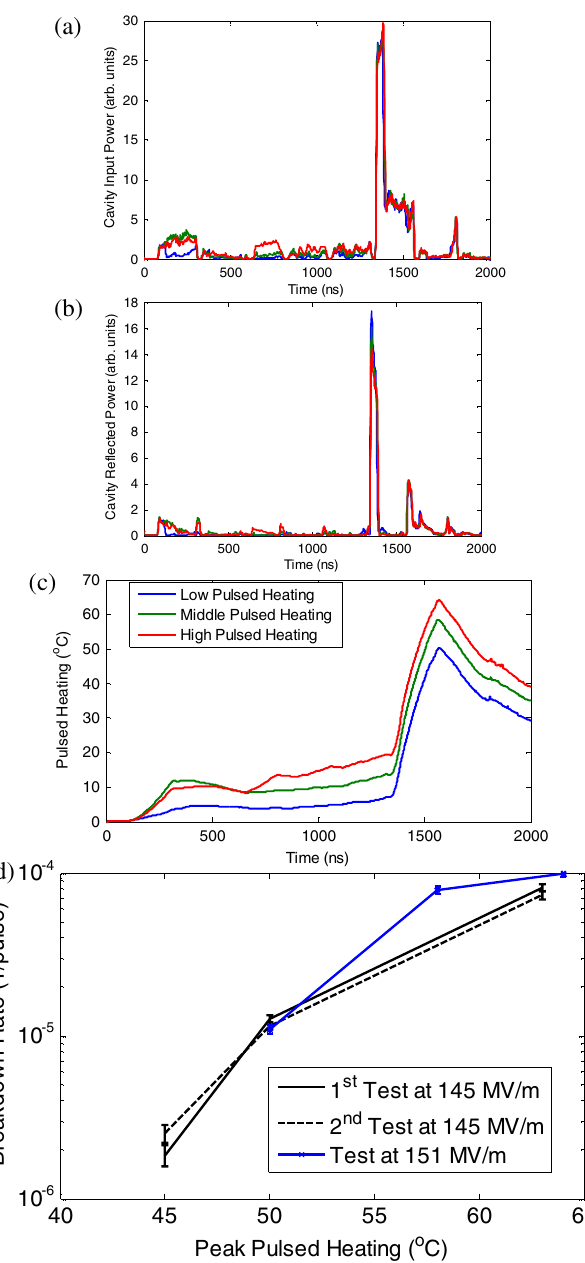
FIG. 5. (a) Input power waveforms, (b) corresponding re- flected power, and (c) peak surface temperature rise profile for X -band single cell SW cavity test runs with similar main input pulses but different prepulses. (d) Test results.